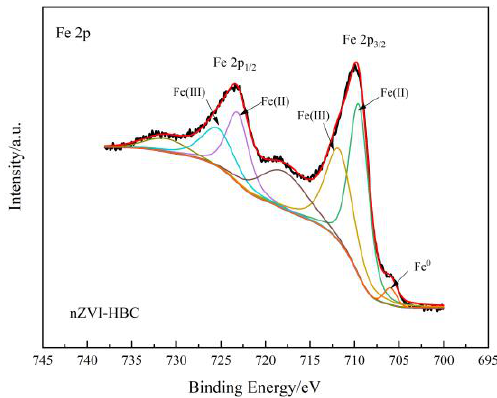
Figure 4. XPS diagram of nZVI-HBC.